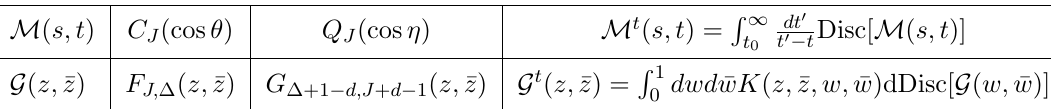
Table 1 . Analogous quantities between the 4-particle scattering amplitude (top row) and the CFT 4-point correlator (bottom row). The right most column shows the dispersion relation. correlator itself. This is the procedure which led in subsection 2.1.1 to a dispersion